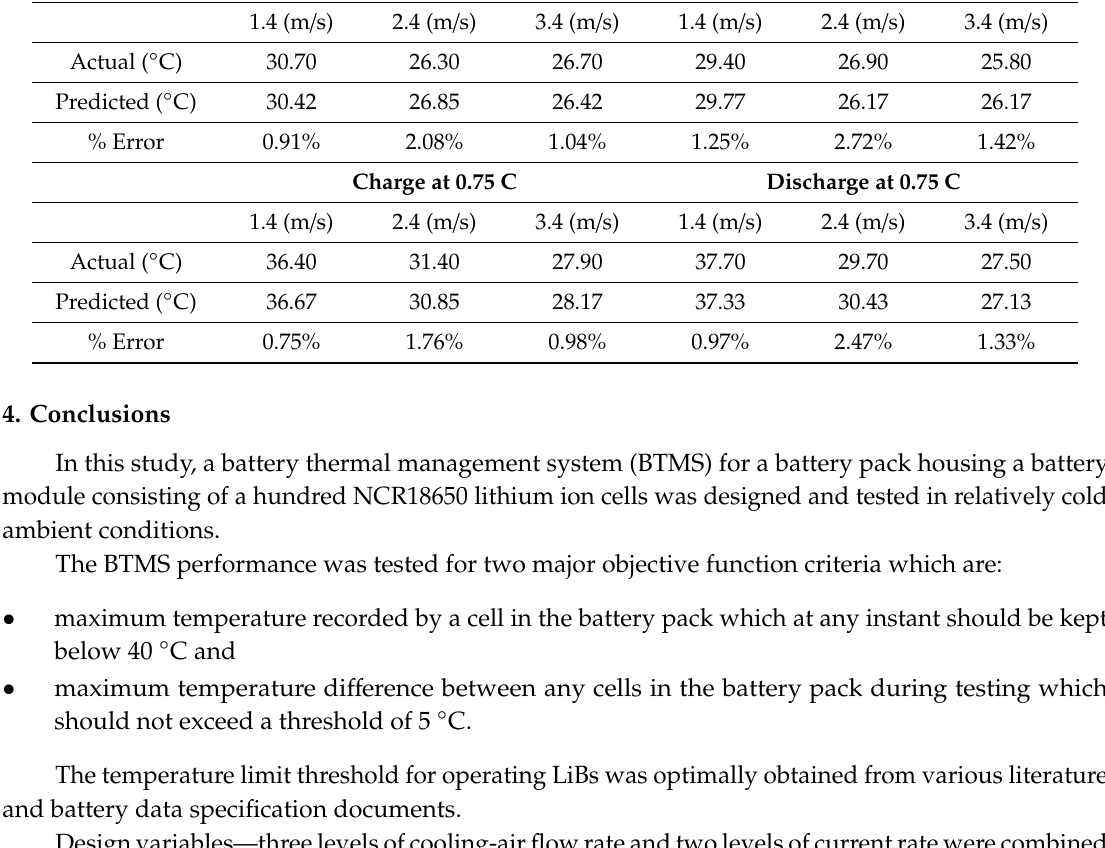
Table 9. Absolute Relative Error between Regression Model and Actual Experiment. Charge at 0.5